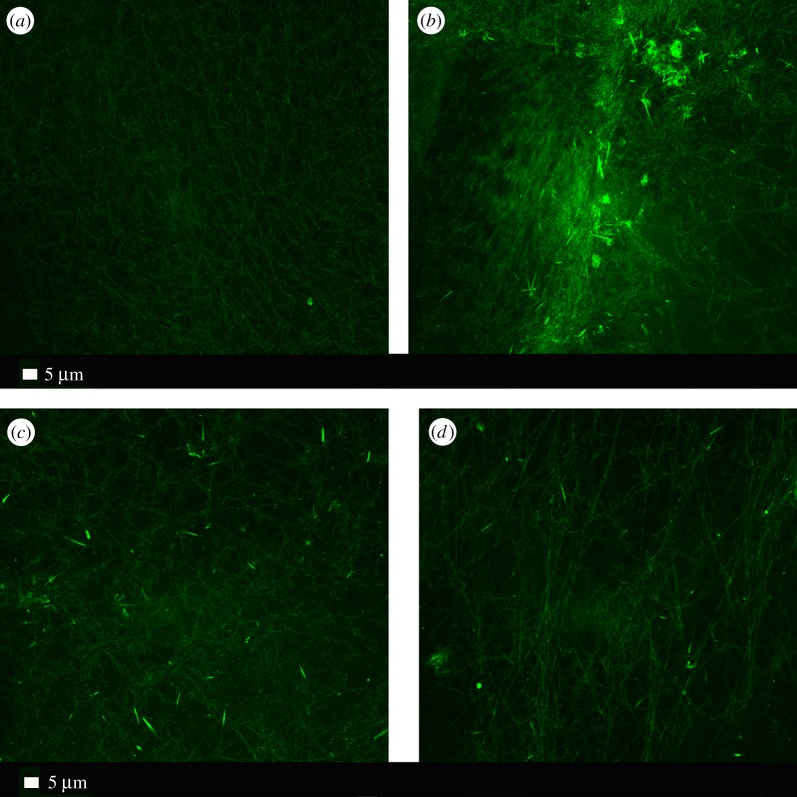
(a) Control PPP with ThT and thrombin and (b) as panel (a) but pre-incubated with 0.2 ng l−1 LPS; (c) as panel (a) but pre-incubated with 2 ng l−1 LBP; (d) as panel (a) but pre-incubated with 0.2 ng l−1 LPS and 2 ng l−1 LBP. (Online version in colour.)